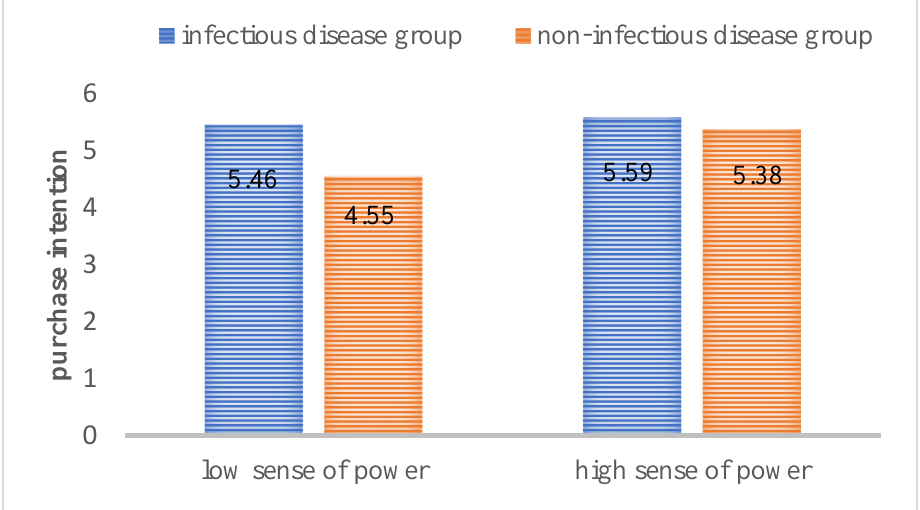
Figure 3. The moderating effect of sense of power on consumers’ purchasing intention of eco- friendly products.